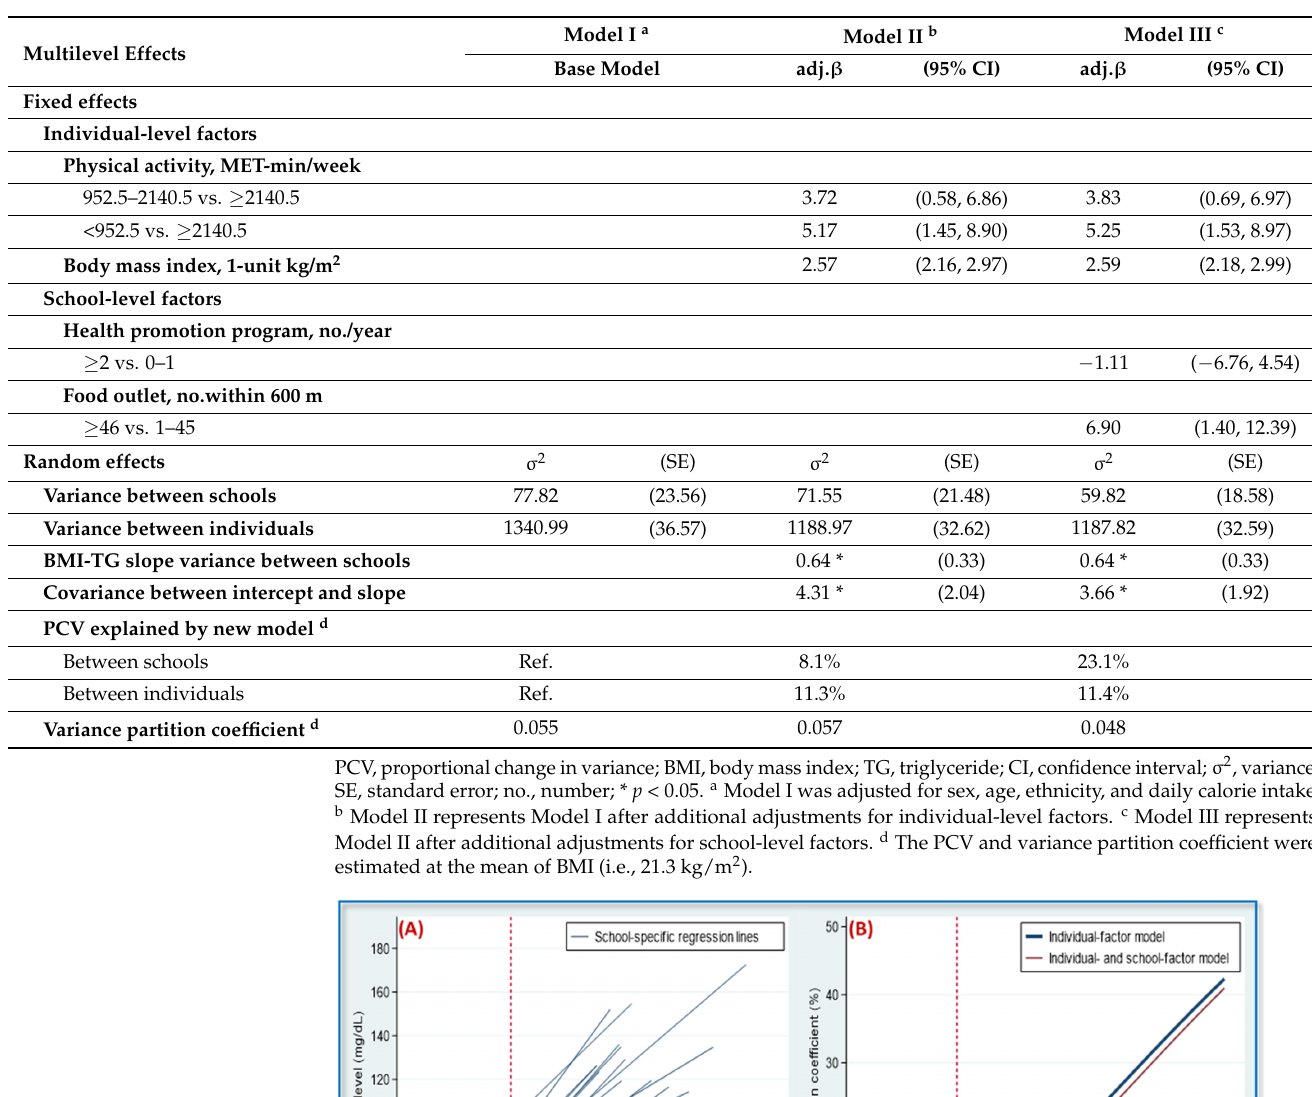
Table 4. The multilevel effects of individual and school factors on triglyceride level (mg/dL) in adolescents.